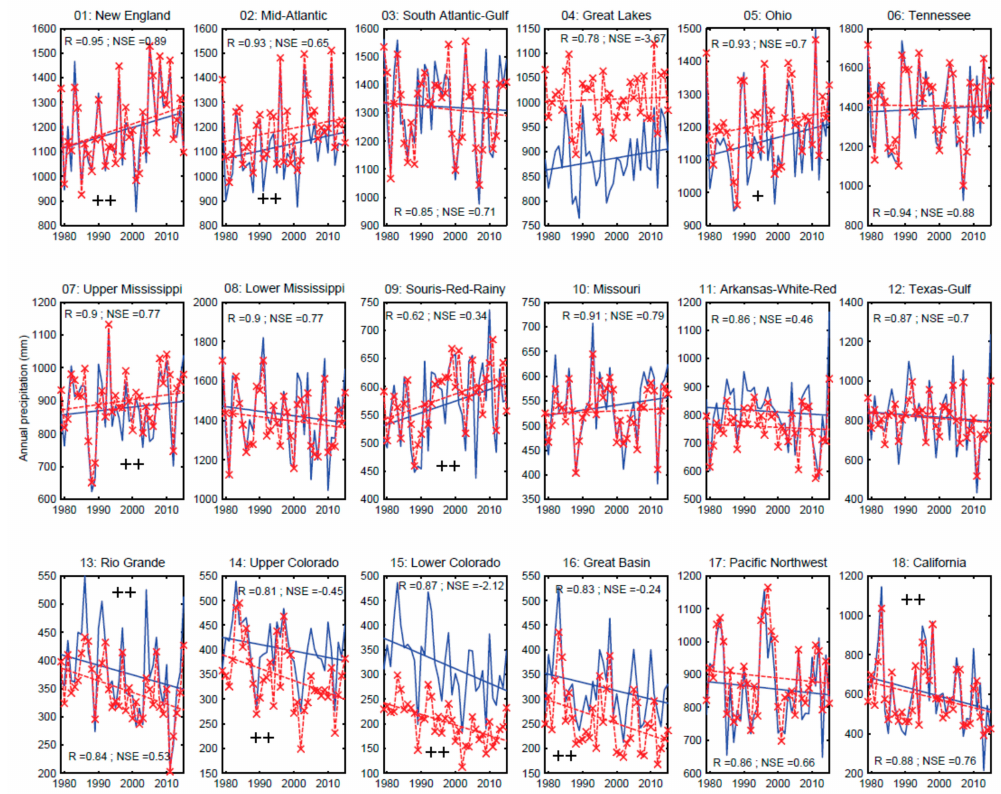
Figure 10. Time series of the HUC2-averaged PRISM (blue) and water-balance-derived annual precipitation rates (1979–2015) with the corresponding least-squares fitted linear tendencies. The trend (by the modified Mann–Kendall test [46]) is significant at the 20%-level for the PRISM values when one plus sign appears, and significant for its water-balance estimates as well when two signs are seen. See the text for explanation of the statistical